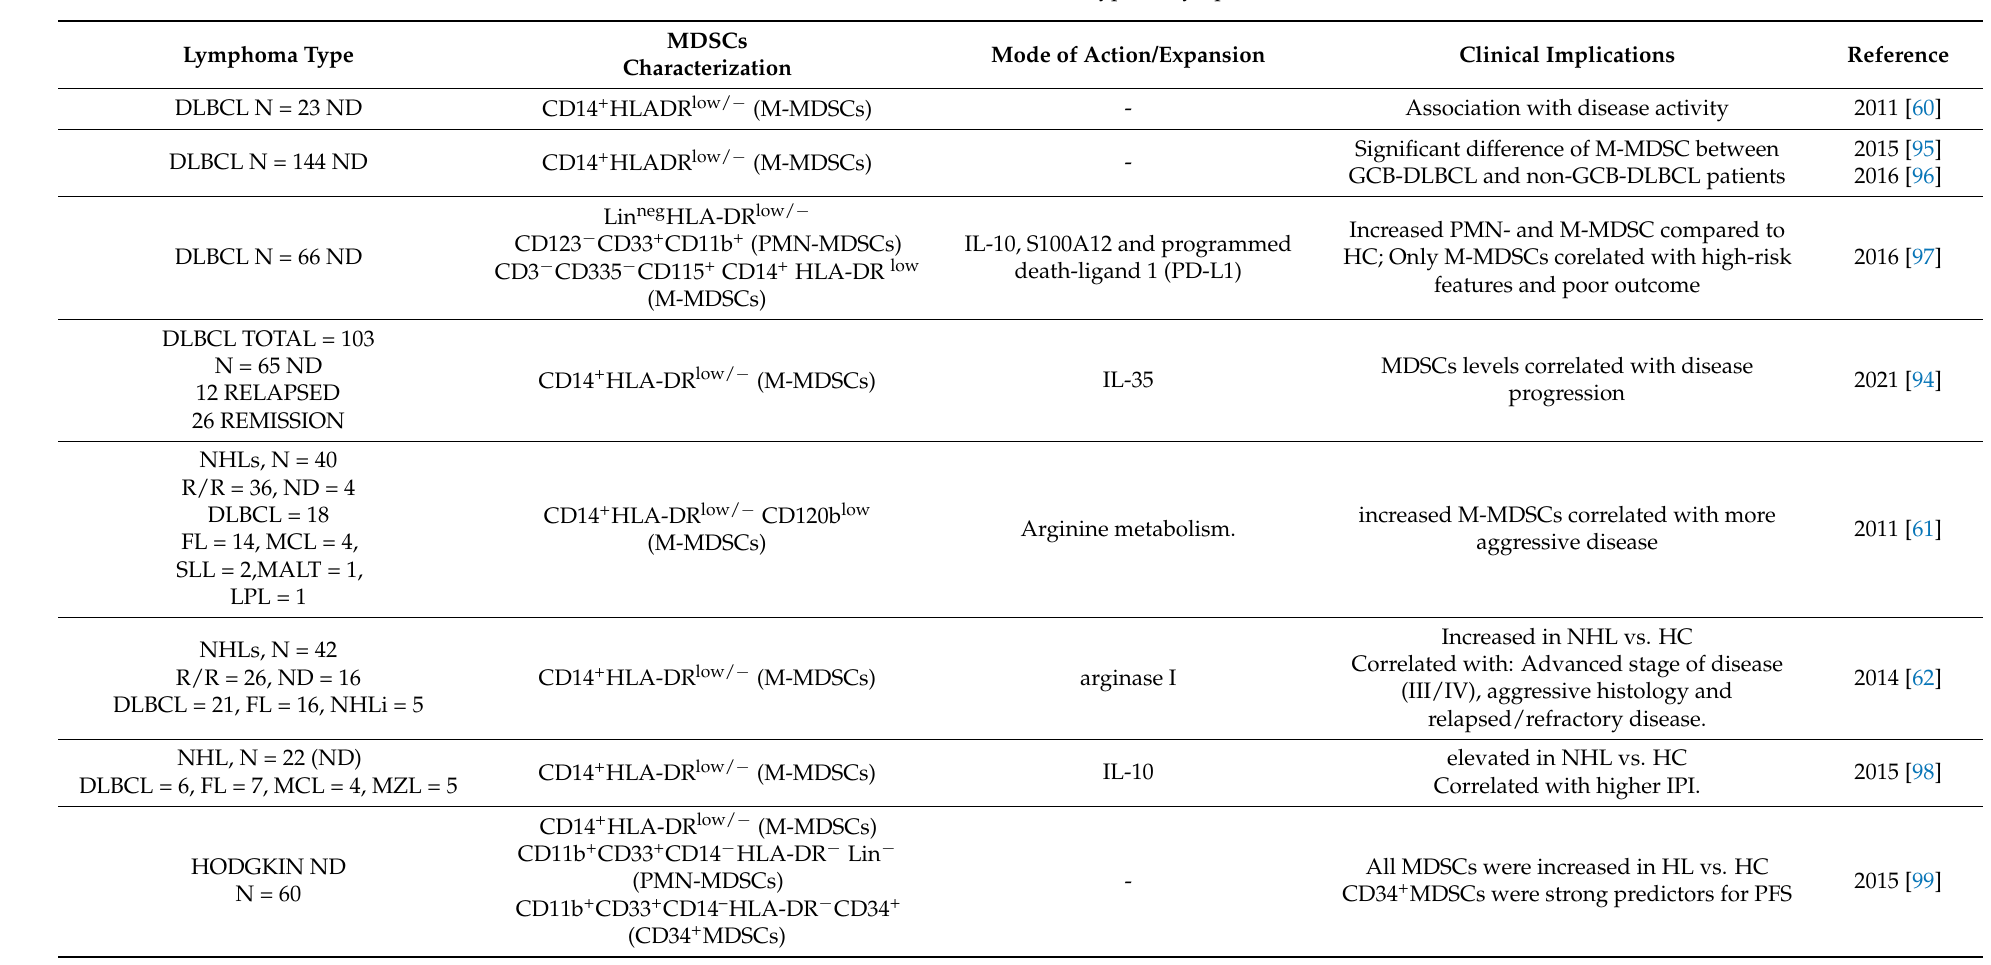
Table 1. MDSC subsets in different types of